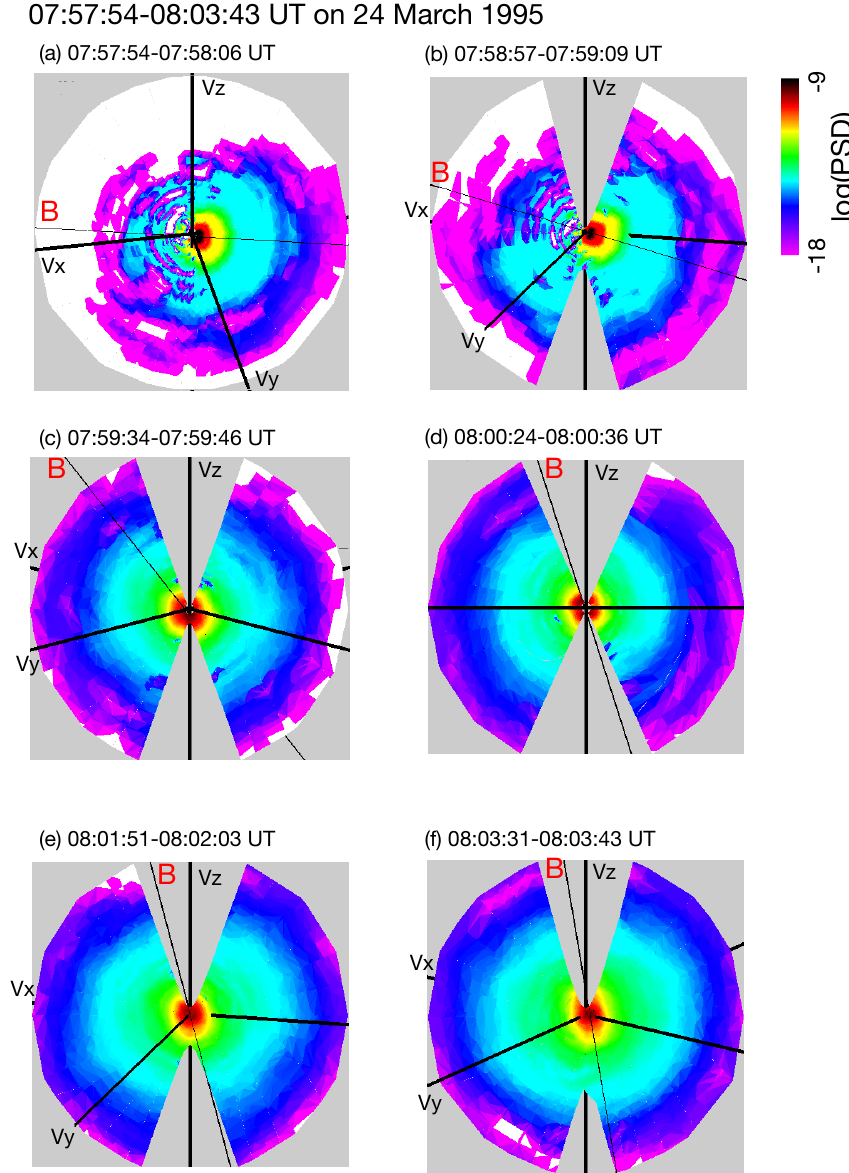
Fig. 5. 2-D cuts of the ion distribution functions for the boundary crossing. Each panel (a–f) corresponds to categorization shown in Fig. 4. Each plane includes the local magnetic field (shown by a narrow black line and indicated by a red letter “B”) and the velocity center from the moment